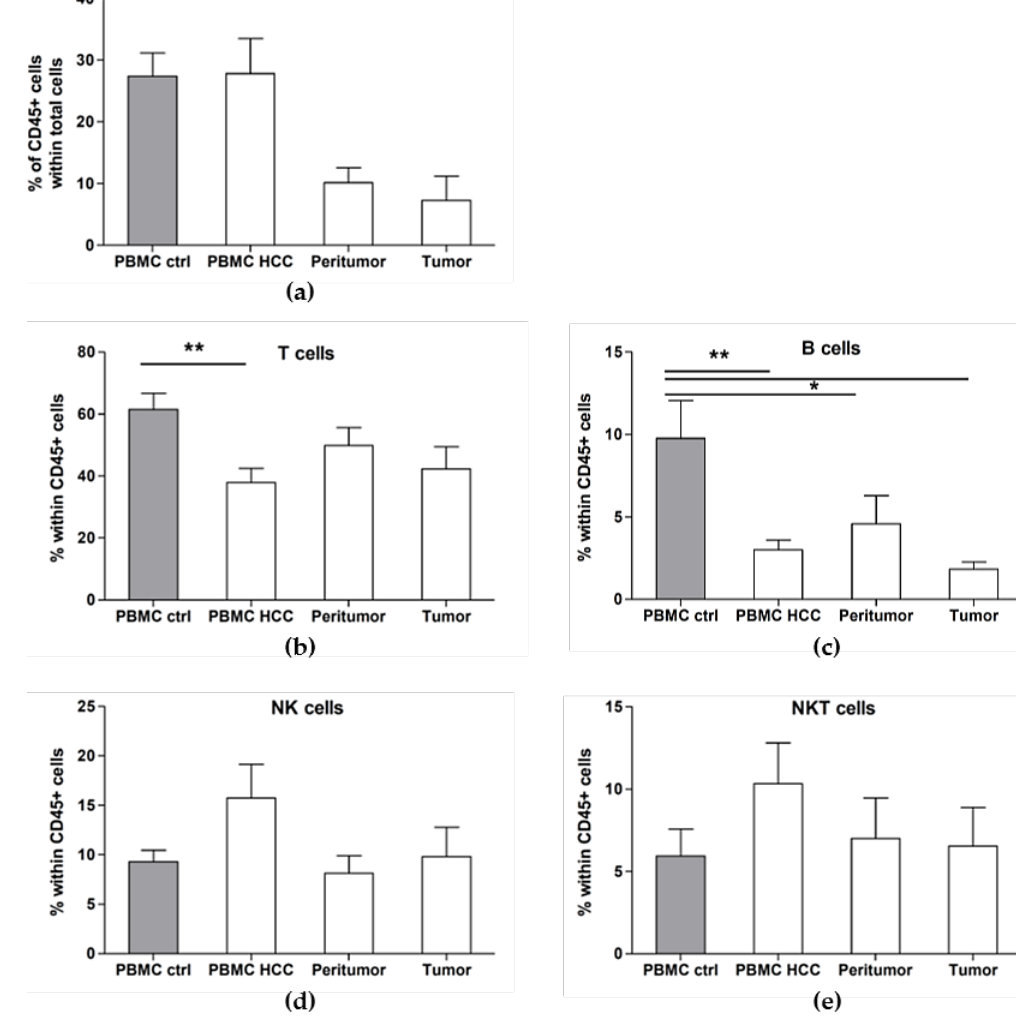
Figure 1. Hepatocellular carcinoma (HCC) patients have imbalanced circulating lymphocyte proportions and an impaired immune infiltration to the tissues. Cell suspensions were prepared from peripheral blood mononuclear cells (PBMC), tumor and peritumor taken during surgery and were analyzed by flow cytometry. The PBMC from healthy donors were used as control. ( a ) Percentage of immune infiltration was identified by the total CD45+ cell portion in each tissue. ( b–e ) Percentage of lymphoid subsets within total CD45+ cells. Grey histograms represent cells obtained from healthy donors, while white histograms represent cells from HCC patients. Results are expressed as Mean ± SEM from cumulative results (n = 9–14 patients or controls). * p < 0.05, ** p < 0.01 and *** p < 0.001, as determined by Mann–Whitney’s test between each lymphoid subset, in each tissue.